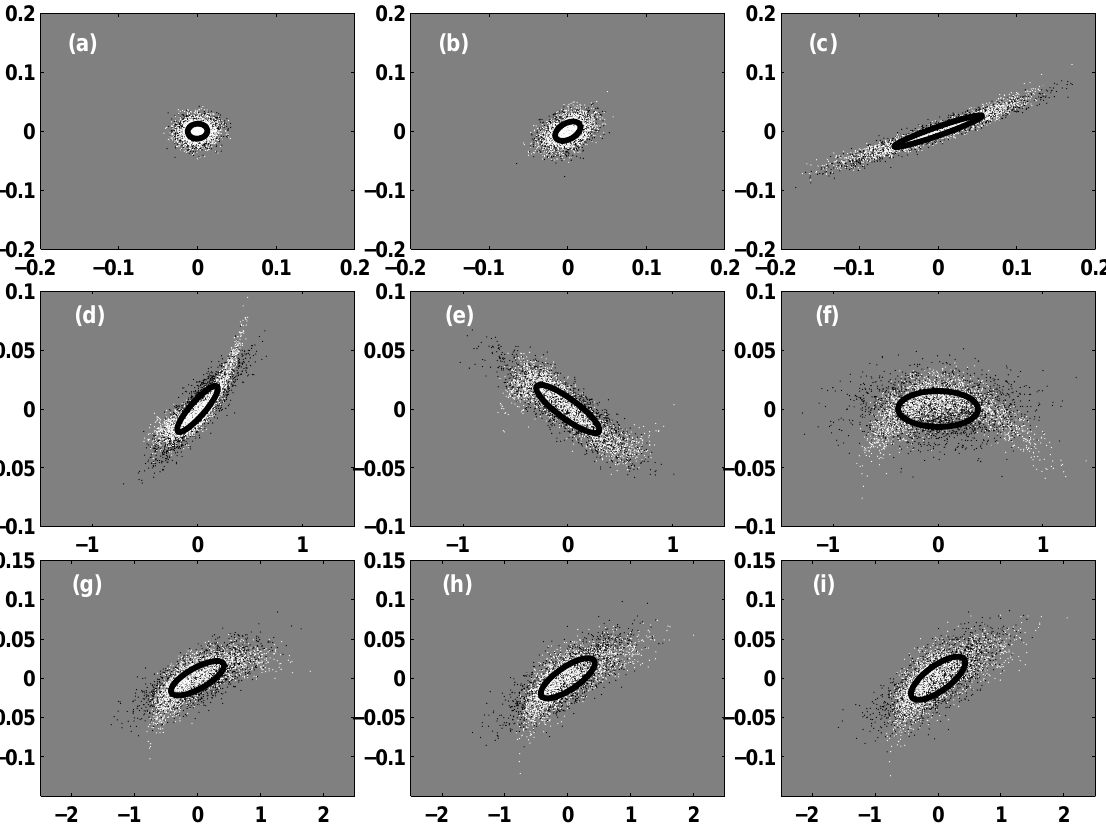
Fig. 5. Particle clouds with the mean position subtracted (white), the ellipse corresponding to the covariance matrix and 10,000 draws from a bivariate Gaussian whose covariance matrix matches that of the particle cloud (black). (a) t = 5 and t increases by 5 units for each panel. The axis labels, “x” and “z” have been removed to make larger sub–panels.